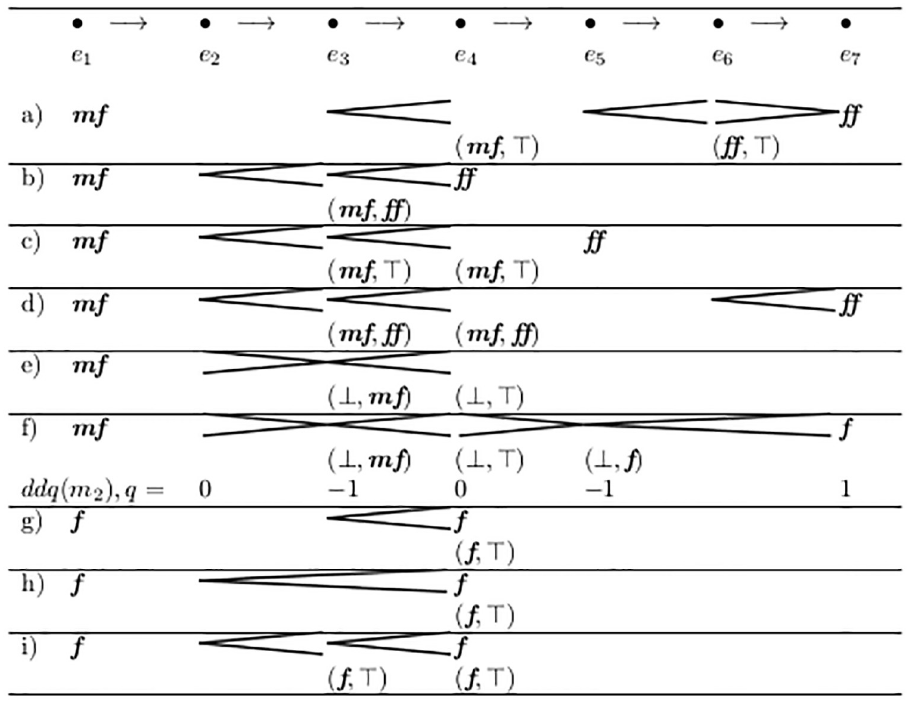
Fig 8. V-analysis of fork ends,